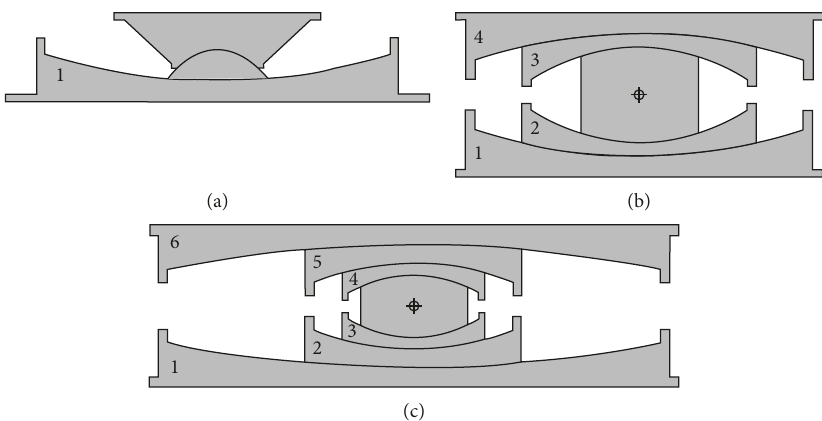
Figure 1: (a) Section view of SFPBs, (b) TFPBs, and (c) QFPBs, where numbers correspond to different sliding surfaces (adopted from [21]).